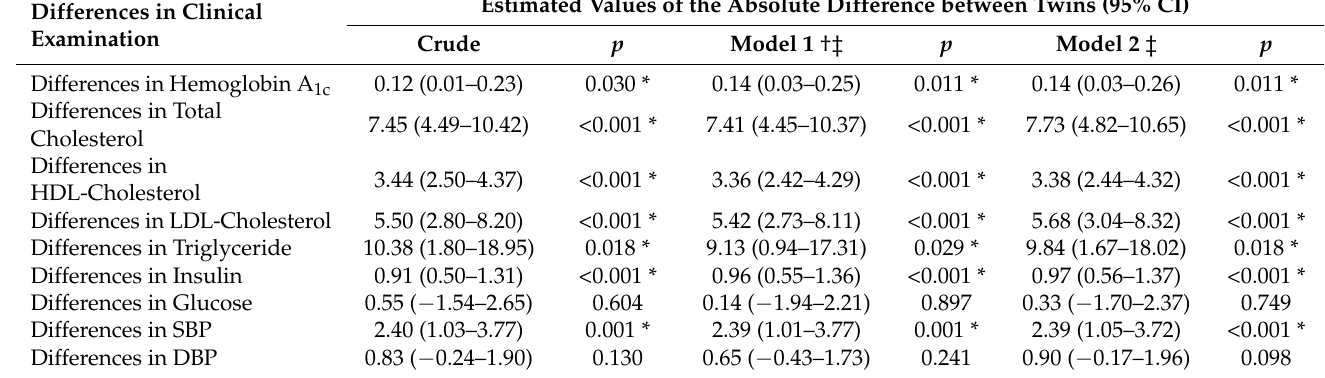
Table 4. Analysis of estimated values of the absolute value of the difference between the matched twins (reference: the absolute value of the difference between monozygotic